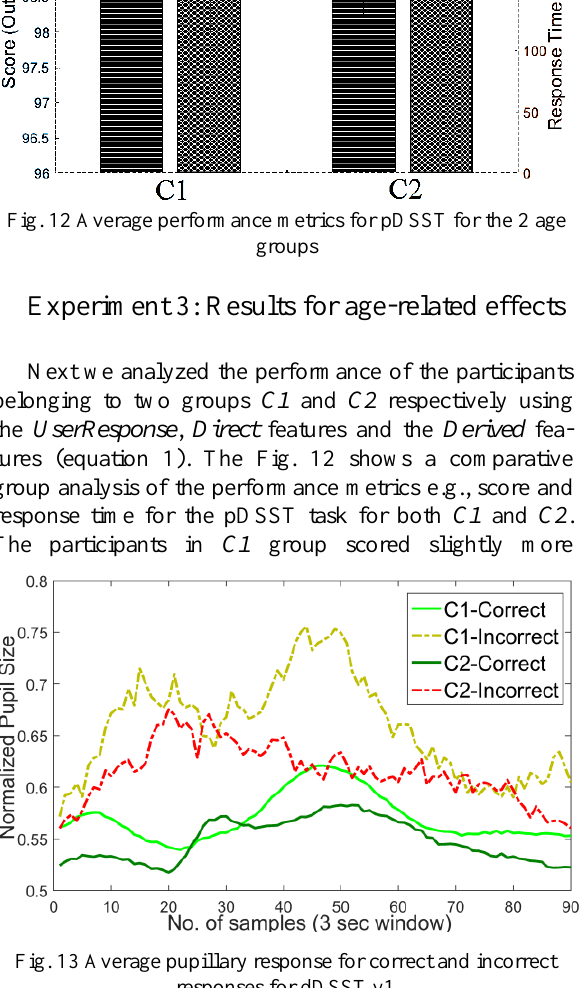
responses for dDSST v1